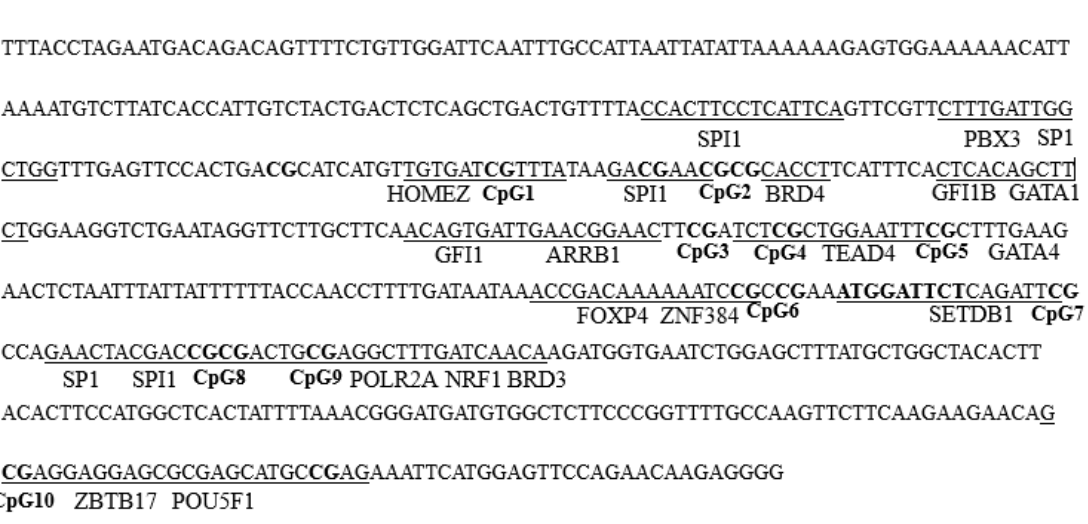
Figure 6. The Ciferritin sequence for DNA methylation detection. The red bold letters indicate the “CpG1-10” loci, and the predicted transcription factor binding sites are underlined.